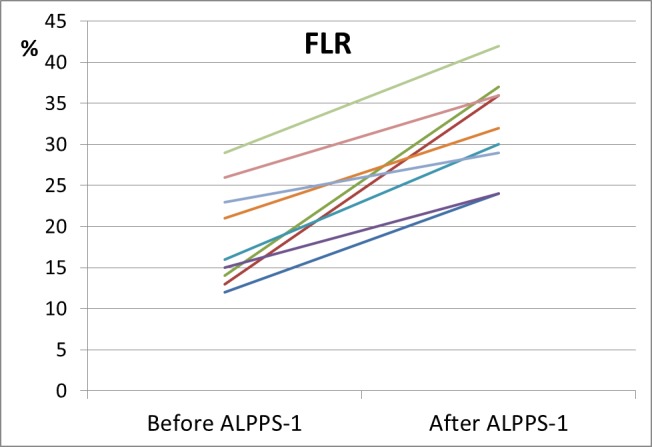
FLR increase between the ALPSS-1 and ALPPS-2 procedures (7.4±2 days).